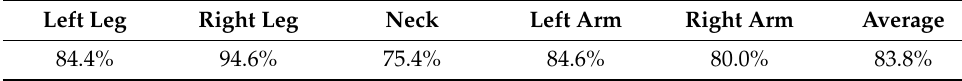
Table 5. Results of reverse joint correction experiment.